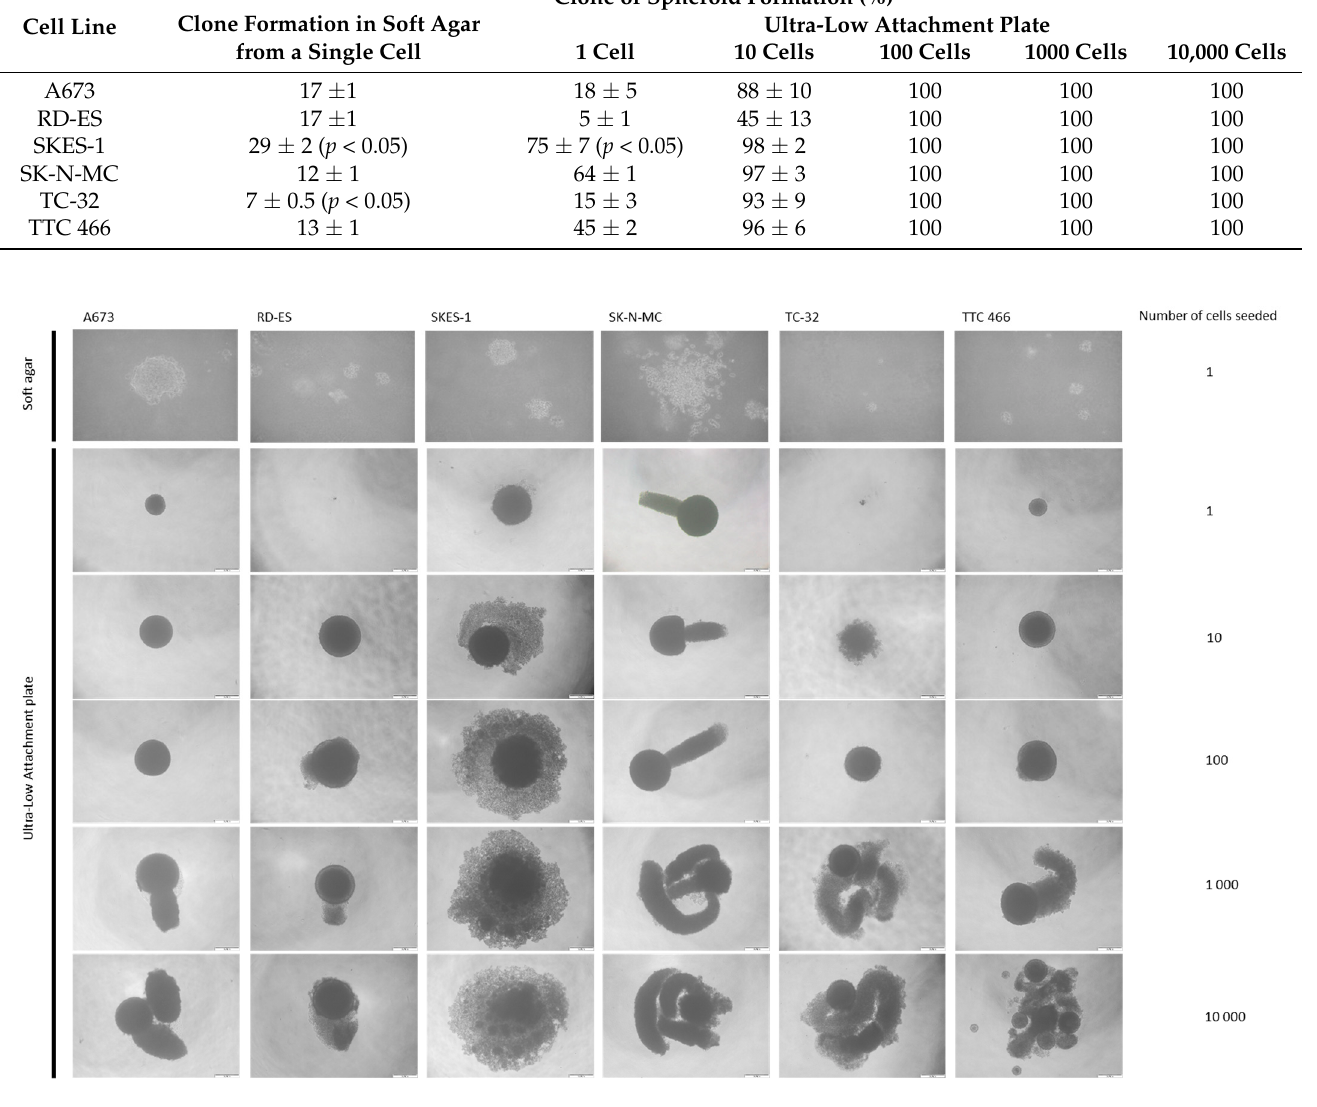
Figure 1. Self-renewing ability of ES cell lines. Single cell suspensions of ES cells were prepared in 0.3% soft agar or 1–10,000 cells seeded into each well of an ultra-low attachment plate (96 wells). Images show colonies formed at 21 days and are representative of three independent experiments. Table 1. Self-renewing ability of ES cell lines. A single cell suspension of each cell line was seeded into soft agar or into a 96 well ultra-low adherence plate at a density of 1–10,000 cells. The number of colonies was counted after 21 days. For studies in soft agar, the mean (±SEM) percentage colony formation is expressed as the number of colonies counted at 21 days relative to the number of cells seeded. For cells seeded onto an ultra-low adherence plate, the mean (±SEM) percentage colony formation is expressed as the number of wells containing a colony of >5 cells relative to the total number of wells with cells seeded. Results are representative of three independent experiments.